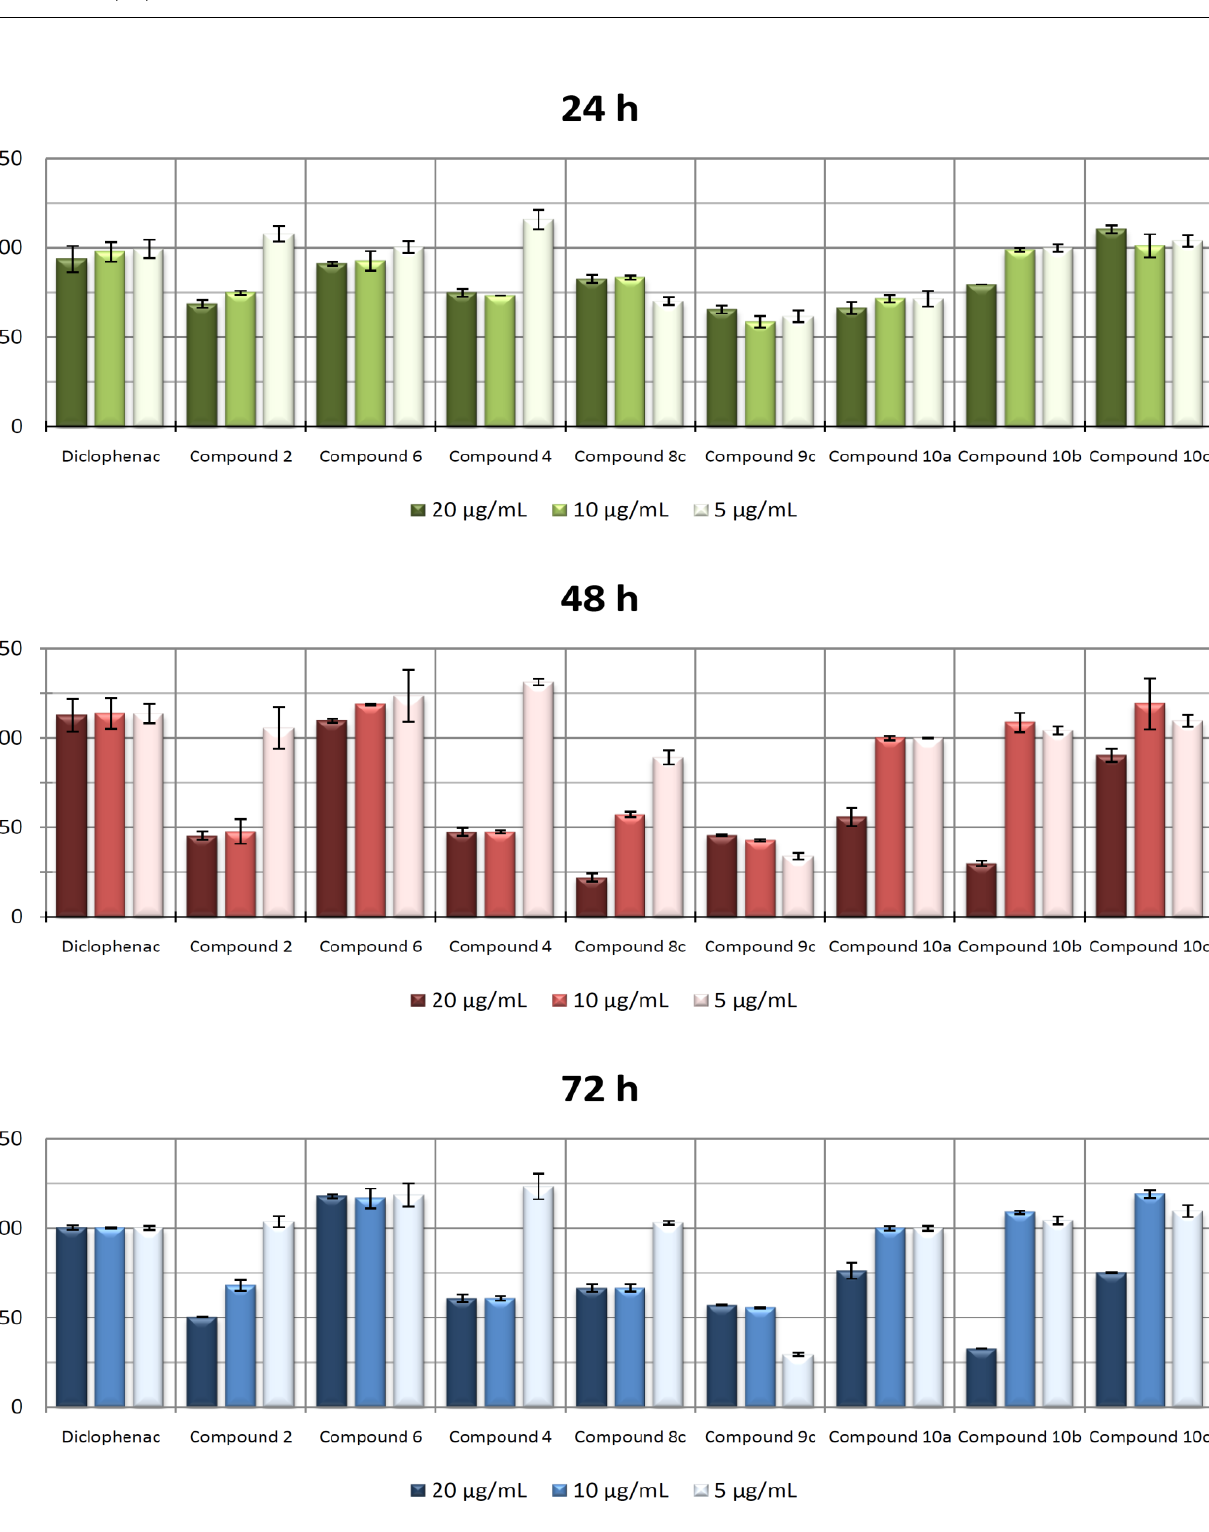
Figure 5. Effect of compounds 2 , 4 , 6 , 8c , 9c , 10a - c, and DCF on the release of nitrites in RAW 264.7 macrophage murine cells. After activation of the inflammatory process, compounds were incubated for 24 h, 48 h, and 72 h at 5, 10, and 20 µg·mL −1 concentrations. The data represent the mean ± S.D. of at least two independent experiments performed in tripli- cate.